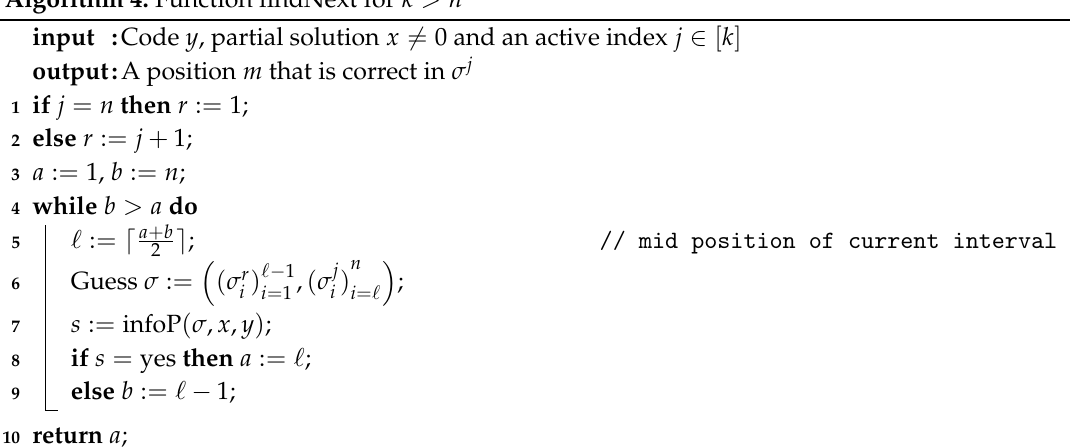
Algorithm 4: Function findNext for k >